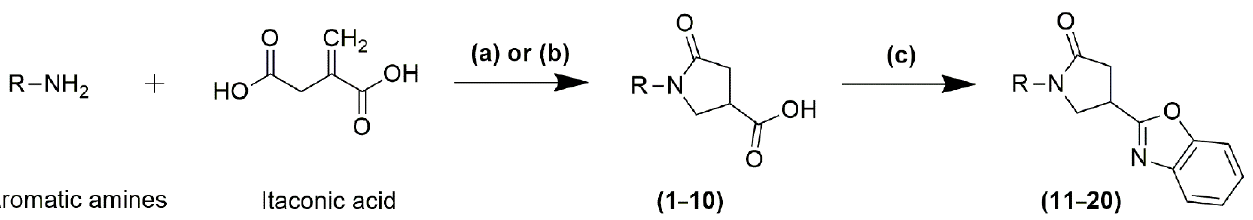
Figure 3. Scheme for synthesis of the intermediates ( 1–10 ) and target compounds ( 11–20 ). ( a ) Reflux in water (Method 1); ( b ) Fusion at 130–140 °C (Method 2); ( c ) 2-aminophenol, polyphosphoric acid, 150–160 °C, sodium carbonate.